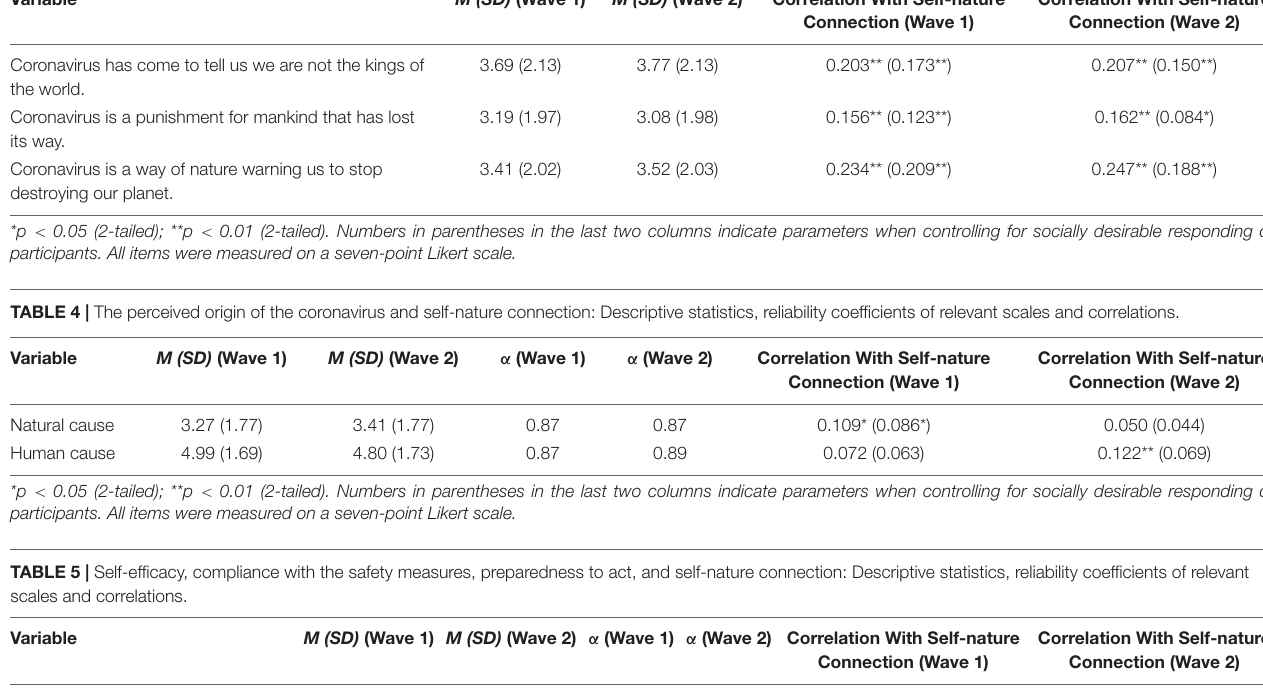
Correlation With Self-nature Connection (Wave 1) Connection (Wave 2)